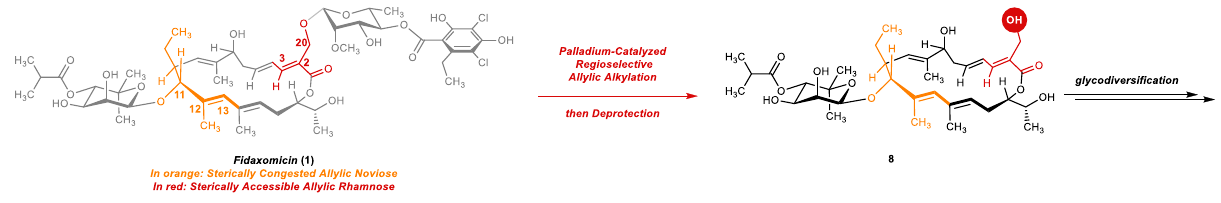
Fig. 9 Site-selective allylic functionalization of (1). Overview of the strategy.